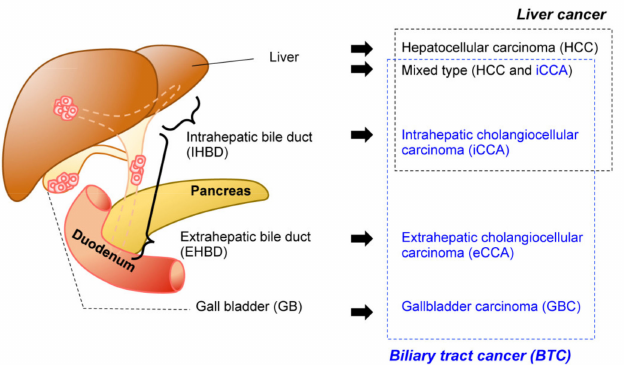
Figure 1. Malignancy of the hepatobiliary system. Anatomical classification of the biliary system (left). The corresponding tumors are listed (right). Biliary tract cancers (BTC) (blue) and liver cancer (black) are not necessarily mutually